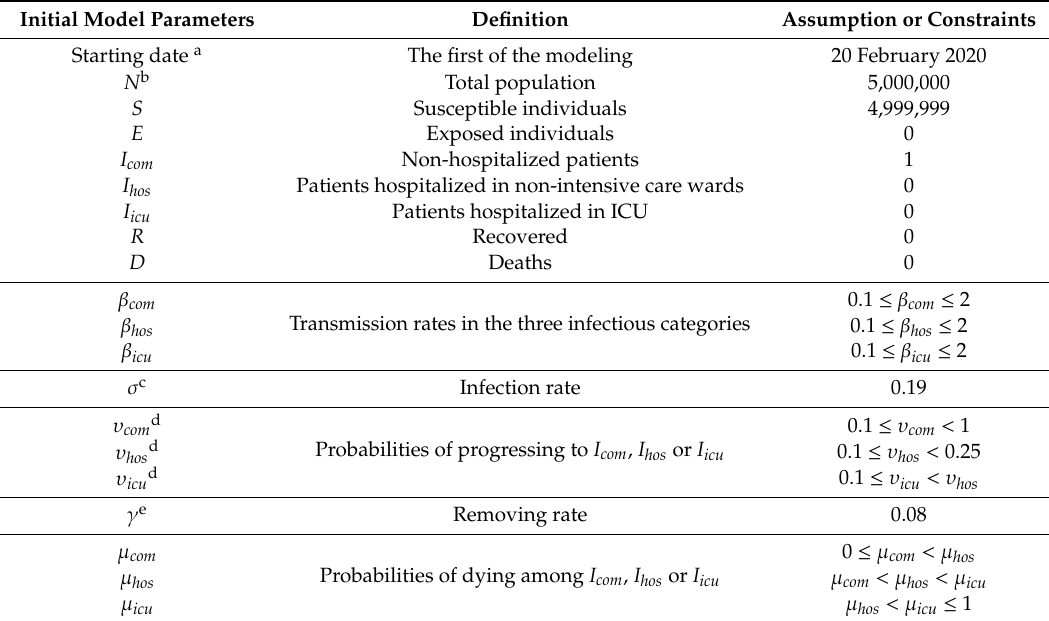
Table 1. Initial parameters of the SEIRD